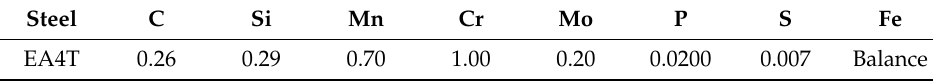
Table 1. Nominal chemical composition of investigated steel material in weight per cent [33].